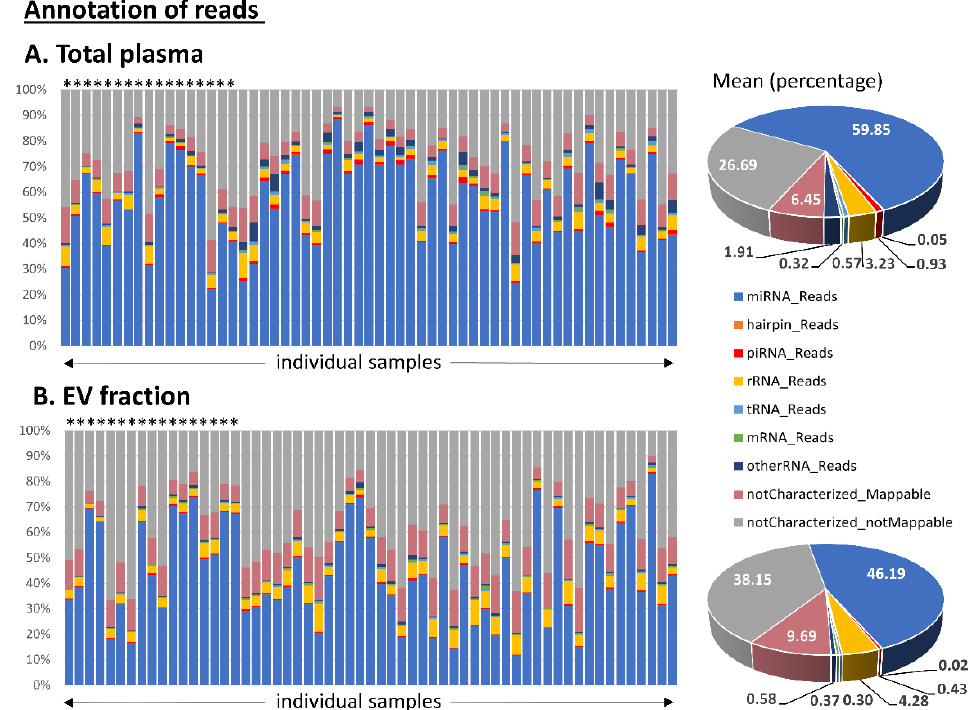
Figure 1. Annotation of small RNA-seq data outputs of ( A ) total plasma samples and ( B ) samples from corresponding extracellular vesicles (EVs). The read percentage was calculated from the total number of annotated read counts after quality control filtering. Healthy control samples are marked with stars above the bars. The pie charts show the mean distribution of reads in the two types of material.